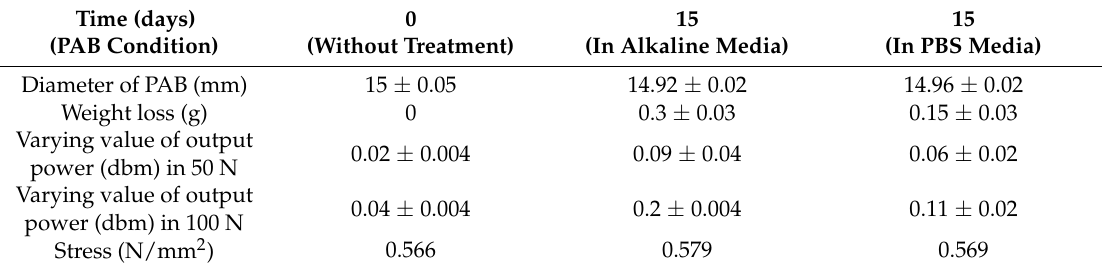
Table 2. Relationship between the degradation time (days) and PAB condition under different immersion